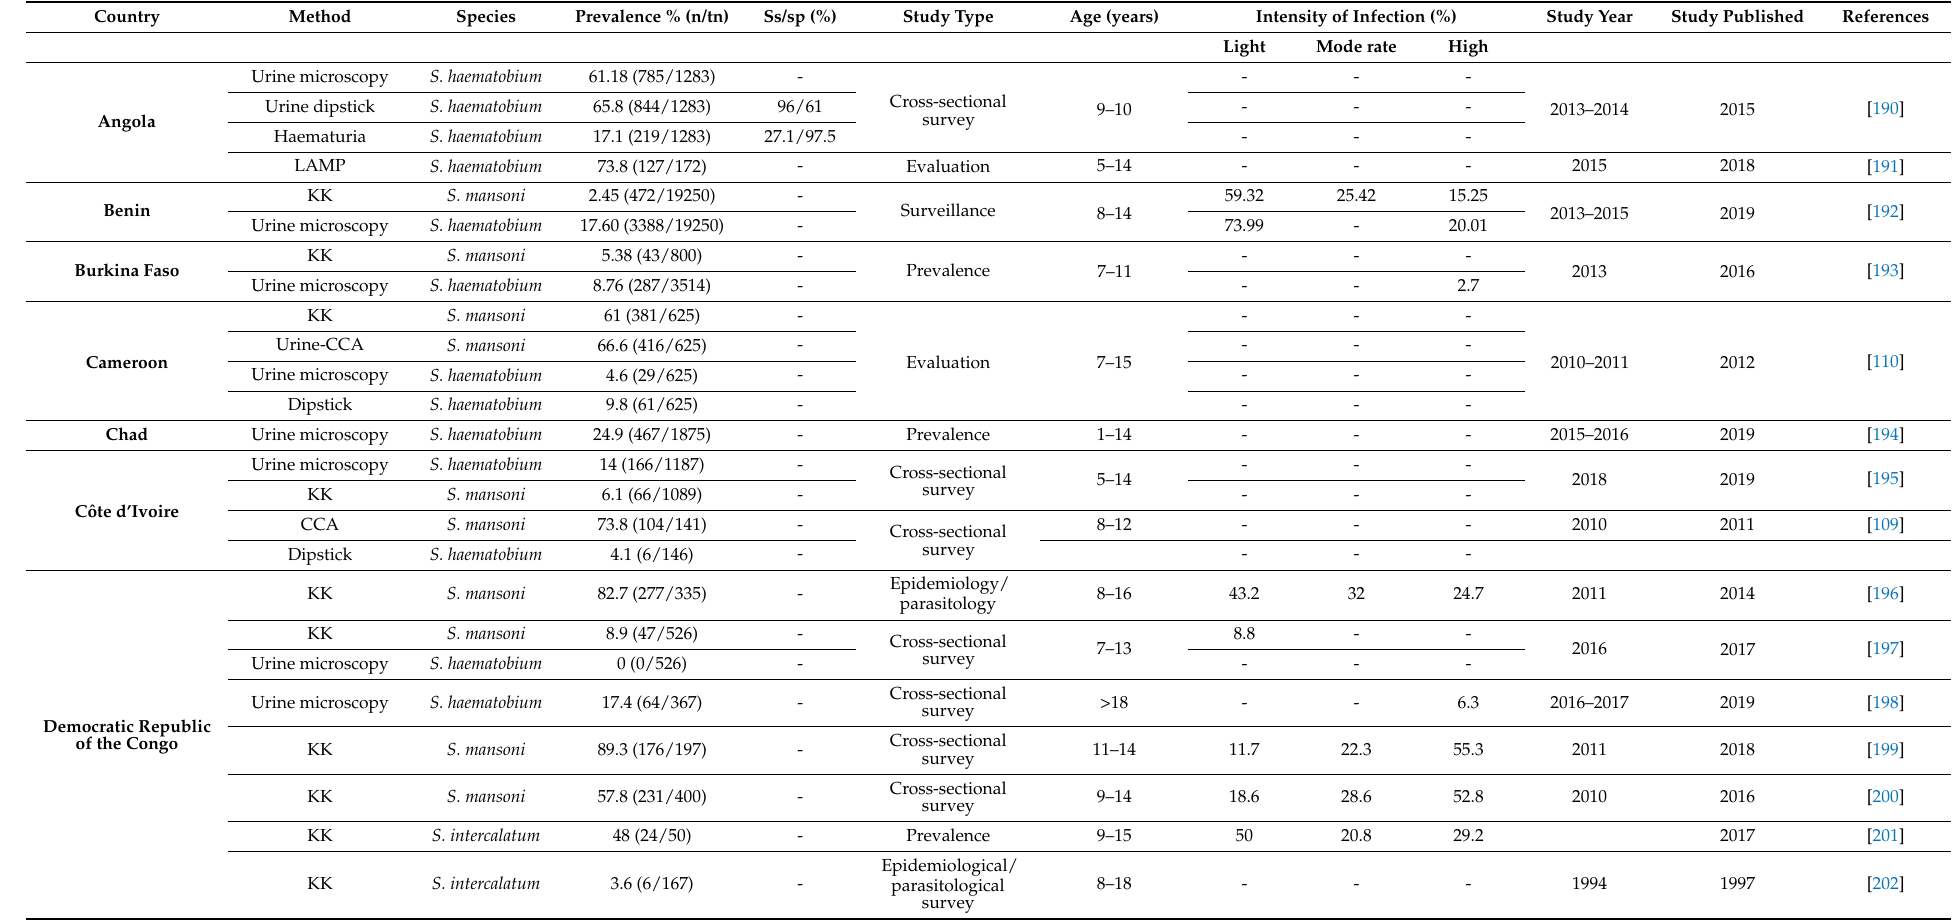
Table 2. The prevalence of schistosomiasis in different African countries. KK—Kato-Katz. qPCR—real-time polymerase chain reaction. POC_CCA—point-of-care circulating cathodic antigen. DDIA—dipstick dye immunoassay. IHA—indirect hemagglutination assay.